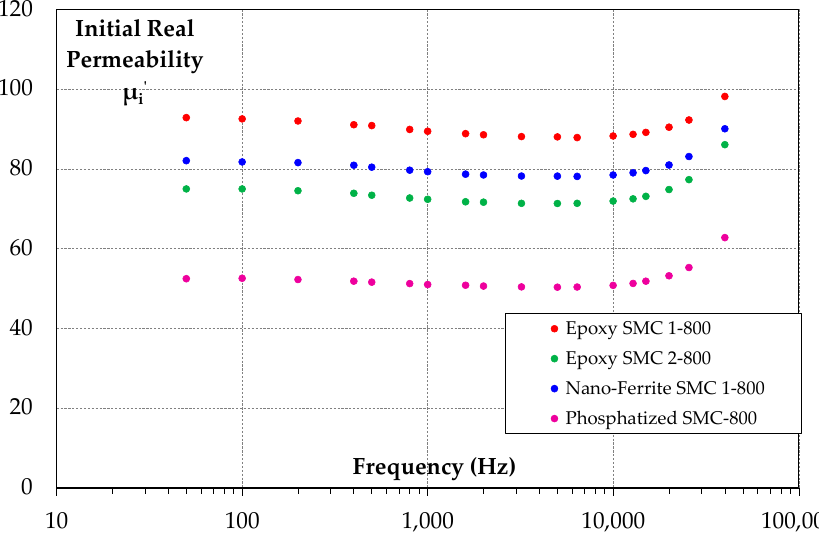
Figure 9. The real part of the initial magnetic permeability of proposed toroid samples in a frequency range of 40 kHz.